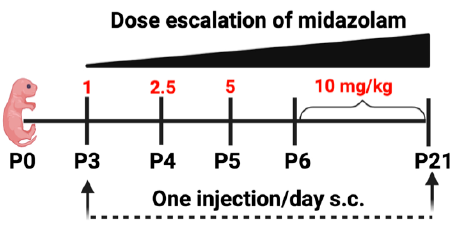
Figure 6. Schematic showing the dose-escalation regimen of midazolam treatment. Pups were then evaluated for four reflex scales: posture, righting, cornea, and tail reflex, as described in [5], to determine the sedation status. The pups were monitored an additional 2–3 times throughout the day, to ensure that they were nursing